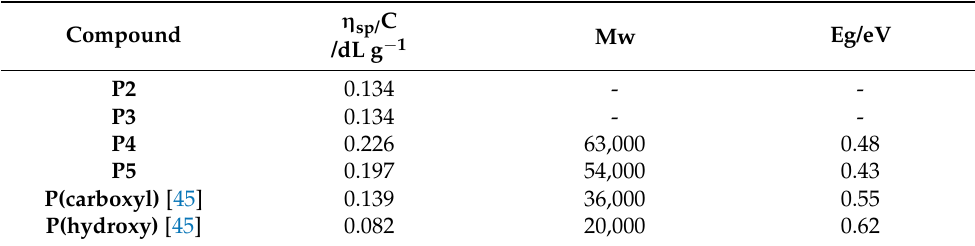
Table 1. Properties of polymers.